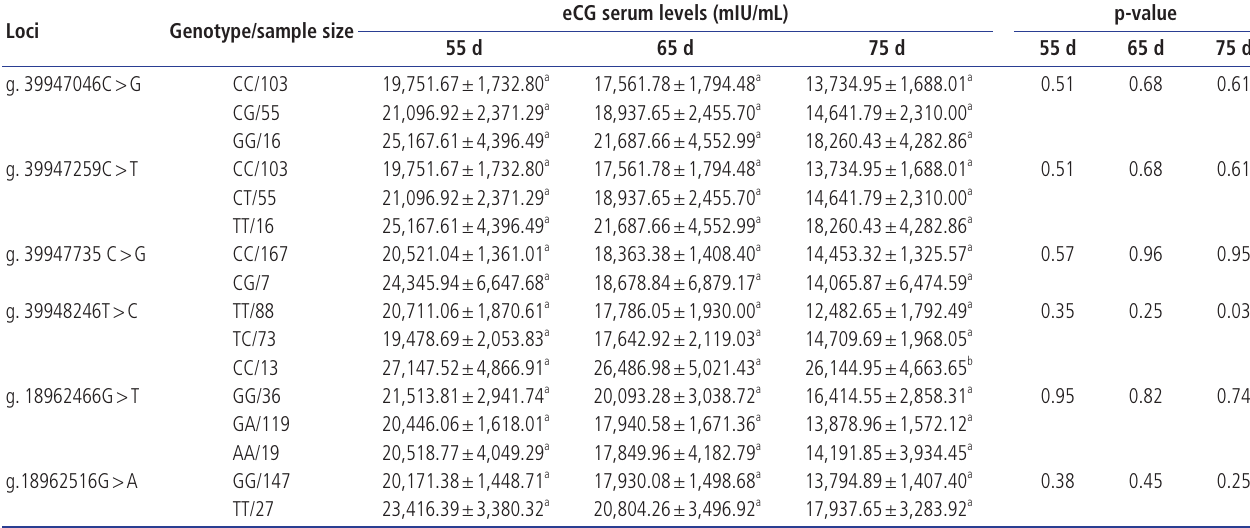
Table 5. The association between the genotypes of eCG genes and the serum eCG levels 1)